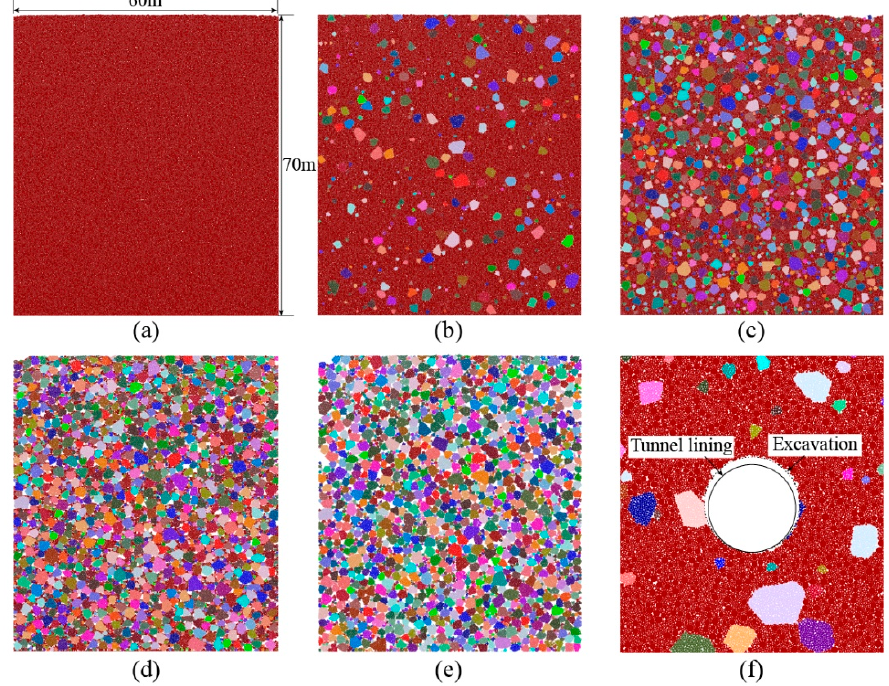
Figure 3. The model setup of the tunnel excavation model: ( a – e ) represent VBPs of 0%, 15%, 50%, 85% and 100%, respectively. ( f ) The tunnel excavation model.